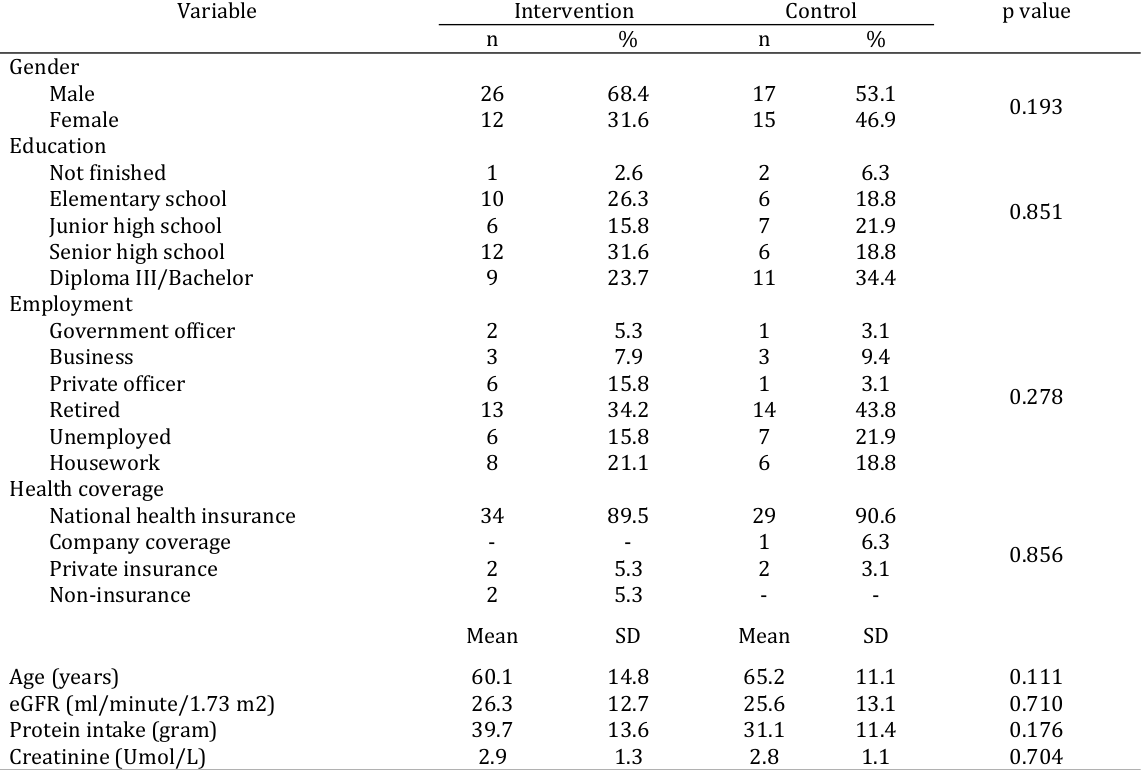
Table 1. Demographic and clinical characteristics of patients with chronic kidney disease undergoing pre-